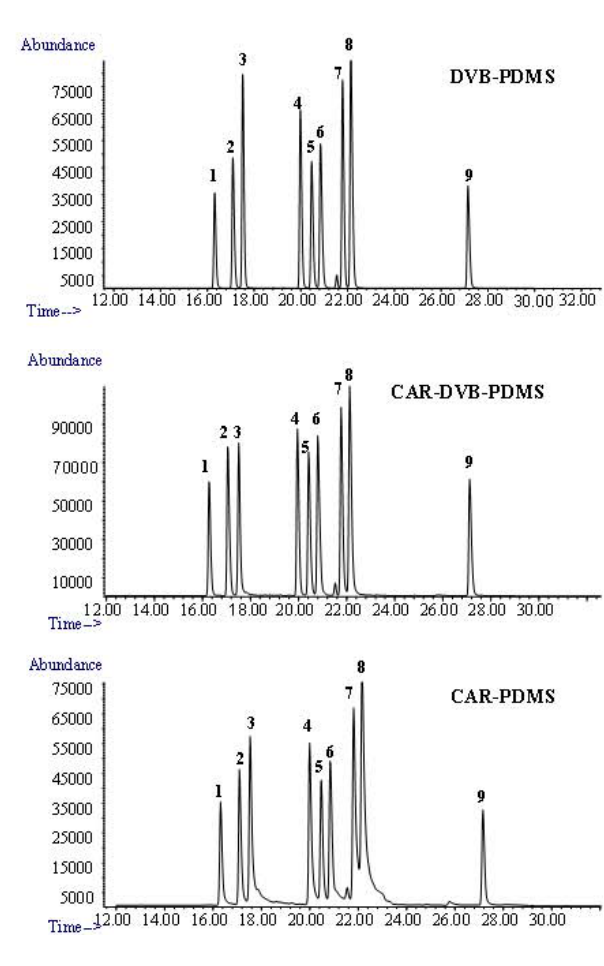
Fig. 4. Reconstructed mass chromatographic profiles ( m / z 93) of monotrpenes sampled with three different SPME fibre coatings with 20 min sampling time.(1): ( − )- α -pinene, (2): (+)- α -Pinene, (3): β -Myrcene, (4): (+)- δ -3-Carene, (5): (+)- β -Pinene, (6): ( − )- β - Pinene, (7): ( − )-Limonene, (8): (+)-Limonene and (9):